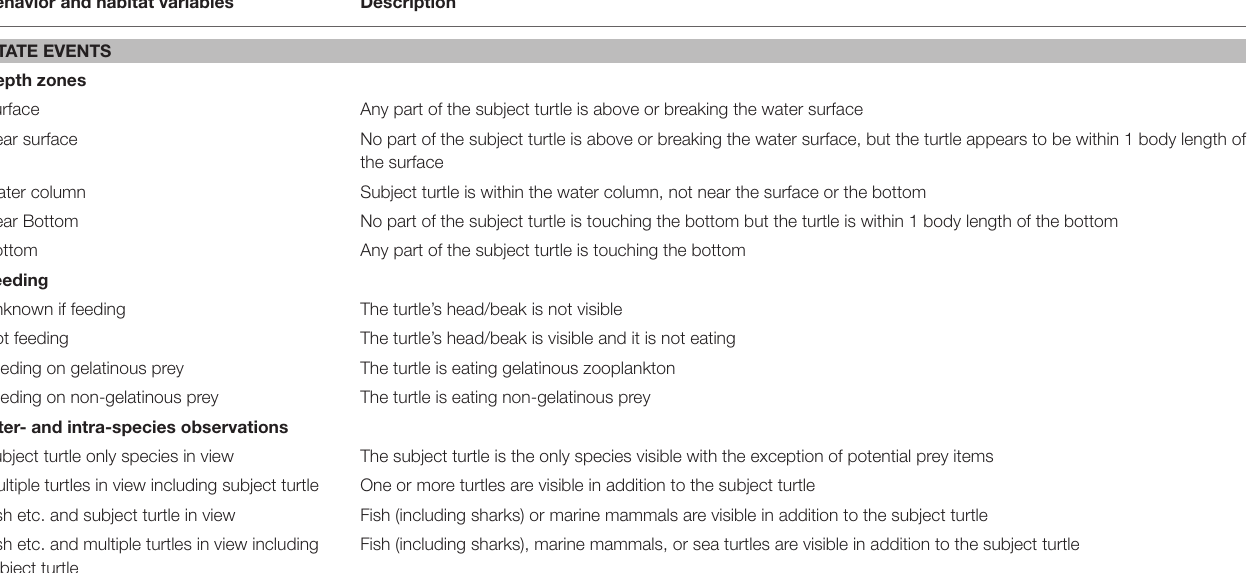
TABLE 1 | Ethogram used to code the video footage. Behavior and habitat variables